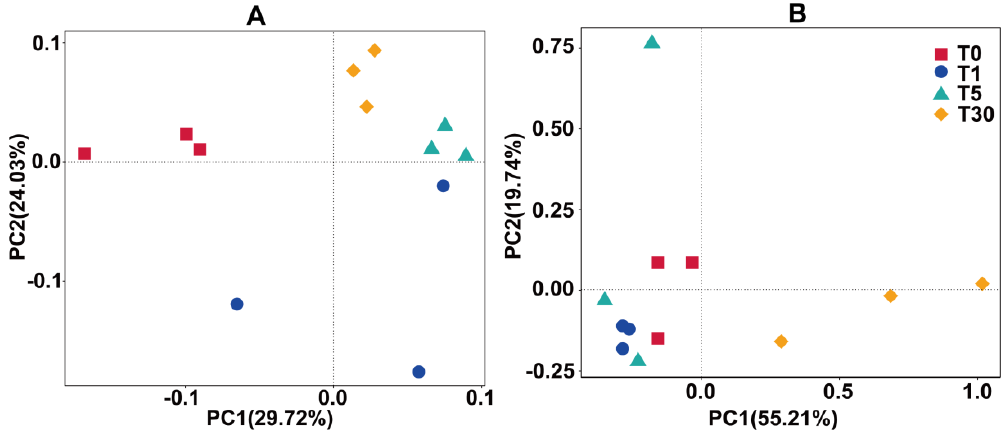
Figure 2. Beta diversity of the microbial community using principal coordinate analysis plots (PCoA) analysis with the weighted_Unifrac metric. ( A ) bacterial community; ( B ) fungal community.